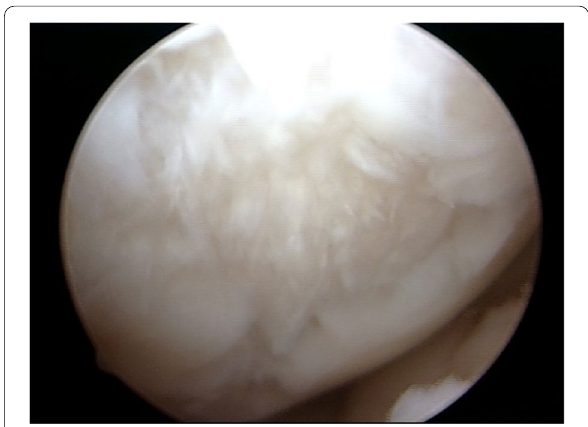
Fig. 2 Medial femoral condyle cartilage lesion, 3.0 well-contained margin. 113